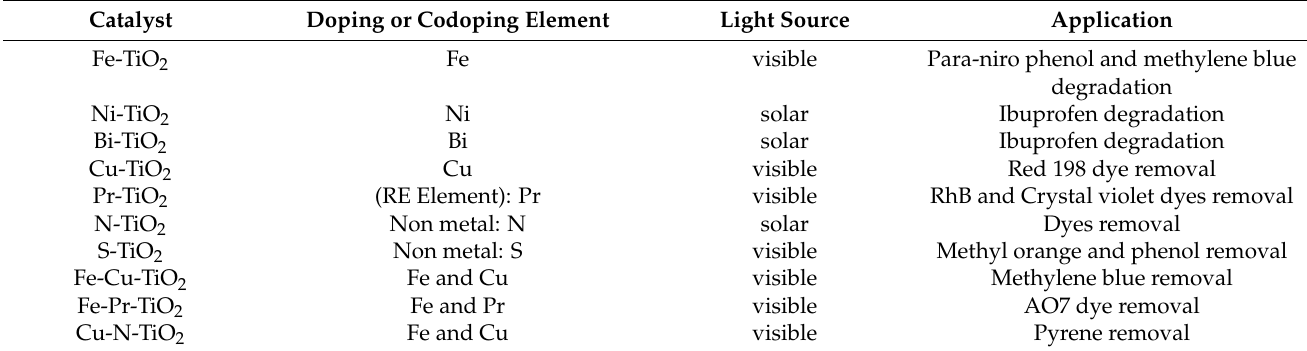
Table 1. Doped and codoped TiO 2 based